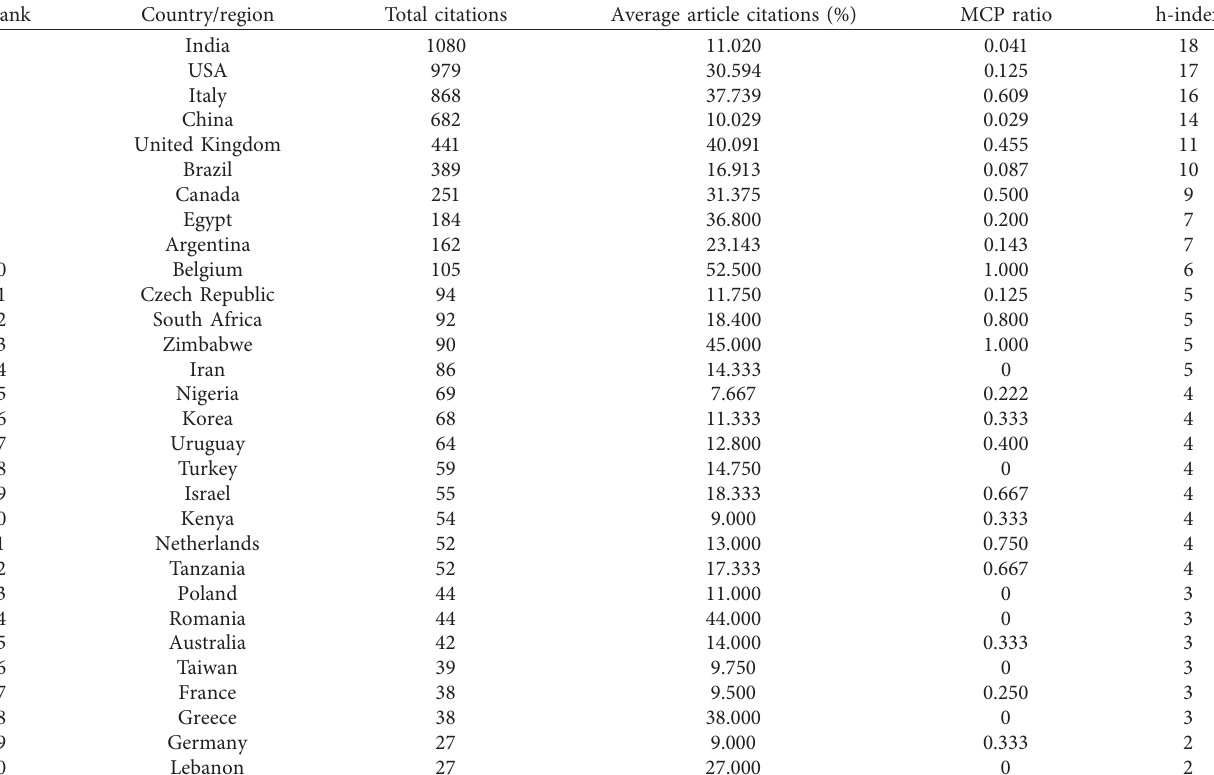
MCPs: multiple country publications.